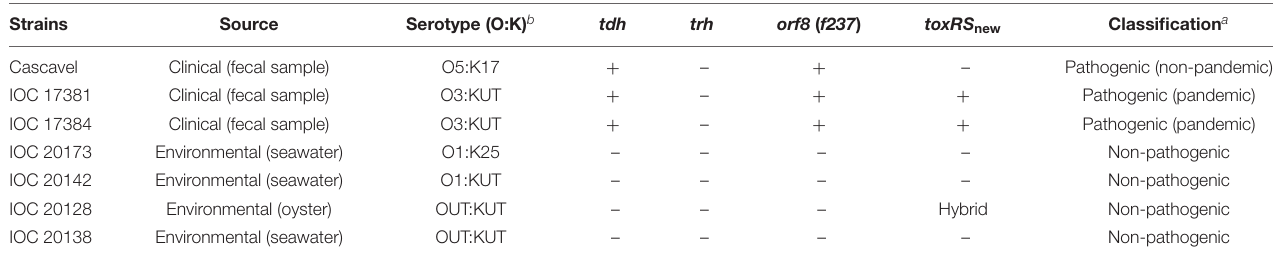
TABLE 4 | Classification of the Vibrio parahaemolyticus strains analyzed in this work based on phenotypic and genotypic characteristics.